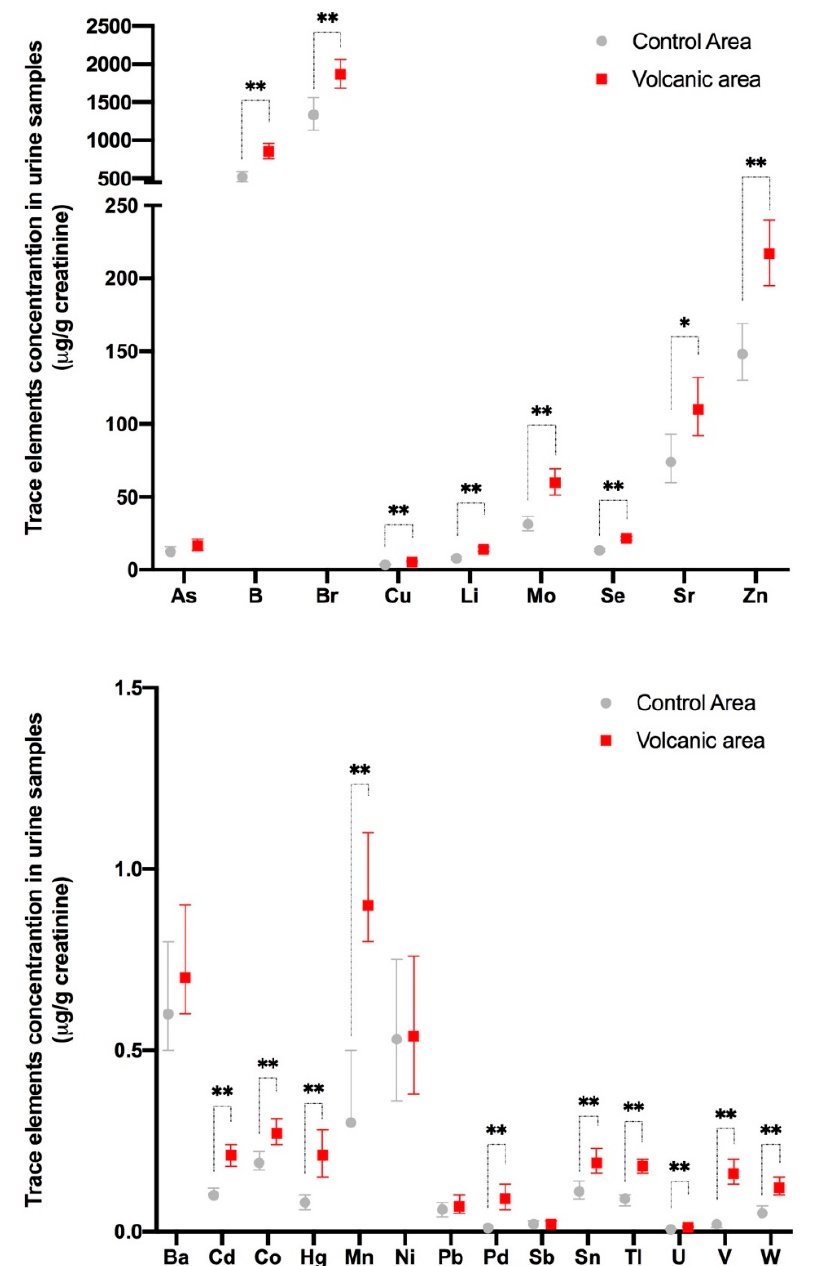
Figure 1. Metal concentrations in the urine of residents of the Mt. Etna volcanic and the control areas in Sicily. Twenty-three metals and metalloids were measured in the urine of 140 randomly selected permanent residents (F = 67.9%, mean age 48.1 ± 16.7 years) of the Mt. Etna volcanic area and 138 residents (F = 66.7%, mean age 46.3 ± 17.1 years) of adjacent non-volcanic control areas. Metal measurements were performed using an inductively coupled mass spectrometer and are expressed as µ g/g creatinine. The values were not normally distributed and therefore the geometric mean was calculated for each specimen, and the values in each group were averaged to determine the mean value and its 95% confidence interval. There were statistically significant differences between the two groups based on linear regression analysis including the log-transformed values of each chemical. For all elements except As, Ba, Ni, Pb, and Sb, the values were significantly higher (* p < 0.05, ** p < 0.01) in the urine of volcanic area residents. Represented data are derived from ref. [25].